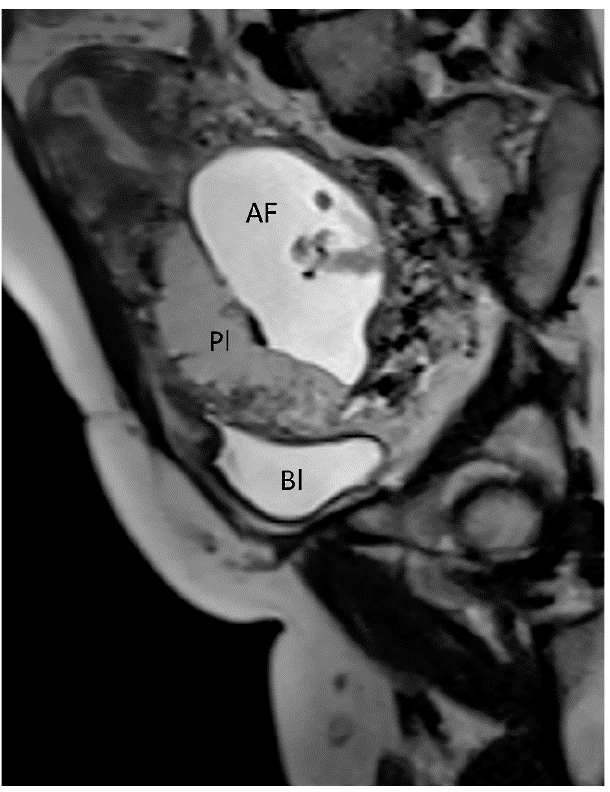
Figure 2. Fetal MRI (13 weeks, sagittal T2) showing an early diagnosis in a case of PAS (placenta accreta, type) (Legend: AF, amniotic fluid; Bl, bladder; Pl, placenta).